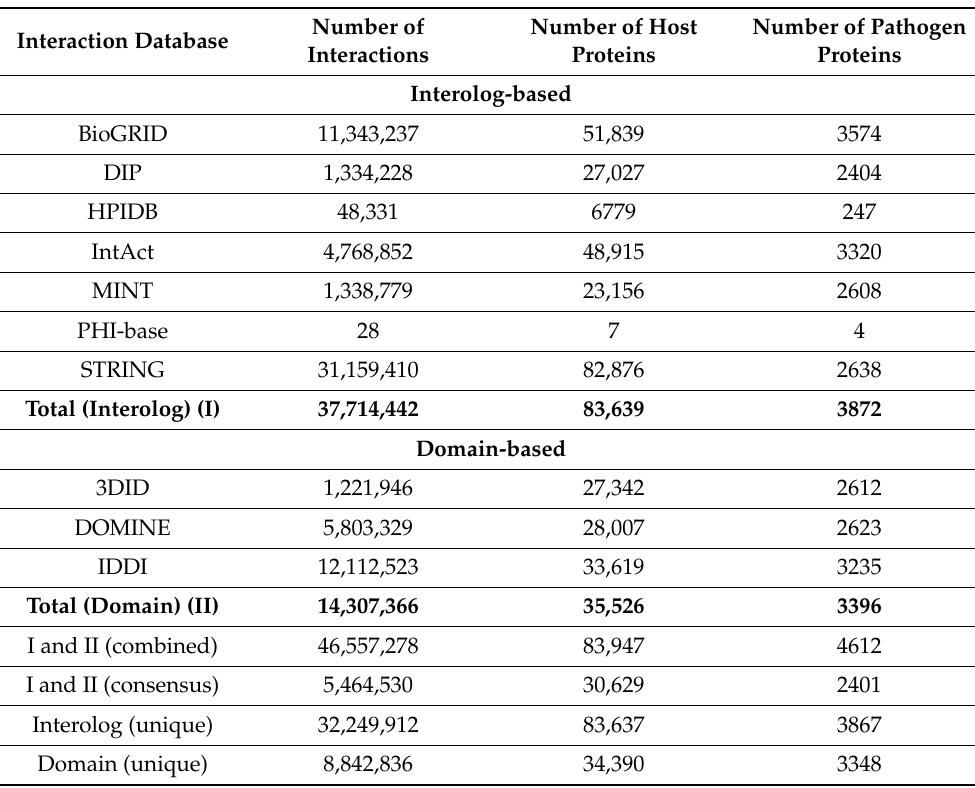
Table 1. Predicted PPIs in T. aestivum – T. caries interactome. Interaction Database